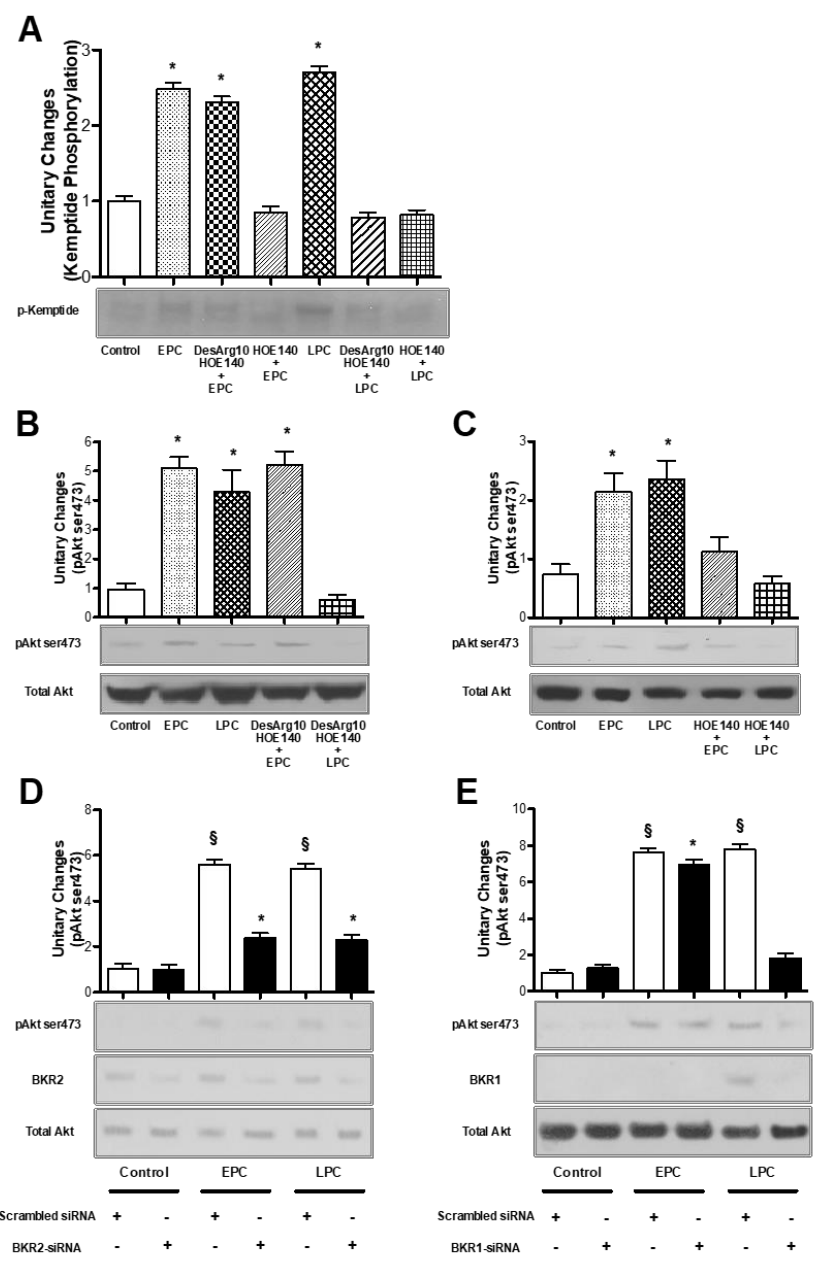
Figure 5. ( A – C ) Early and late preconditioned bAECs, in the absence and presence of selective bradykinin receptor 1 (BKR1) and 2 (BKR2) inhibitors (desArg10-HOE-140 and HOE-140, respectively), were harvested and lysed. The phosphorylation of kemptide ( A ) and Akt ( B , C ) was assessed. The bar graph represents densitometric analysis, with the mean ± SEM, expressed as fold increase in protein phosphorylation over that in control cells, of three independent experiments. ( D , E ) bAECs were transfected with bovine BKR2- and BKR1-short interfering RNA (BKR2-siRNA and BKR1-siRNA, 20 µ g), then subjected to EPC and LPC. Akt phosphorylation at serine473 residues and BKR2 and BKR1 protein expression were assessed by immunoblotting. The bar graph represents densitometric analysis, with the mean ± SEM, expressed as fold increase in protein phosphorylation over that in control cells, of three independent experiments. EPC: early preconditioning; LPC: late preconditioning. * p < 0.001 vs. control; § p < 0.001 vs. control and siRNA transfection, by one-way ANOVA with a post hoc test of HSD. Together, these experiments indicate that, during PC, BKR2 plays a pivotal role in PKA and Akt